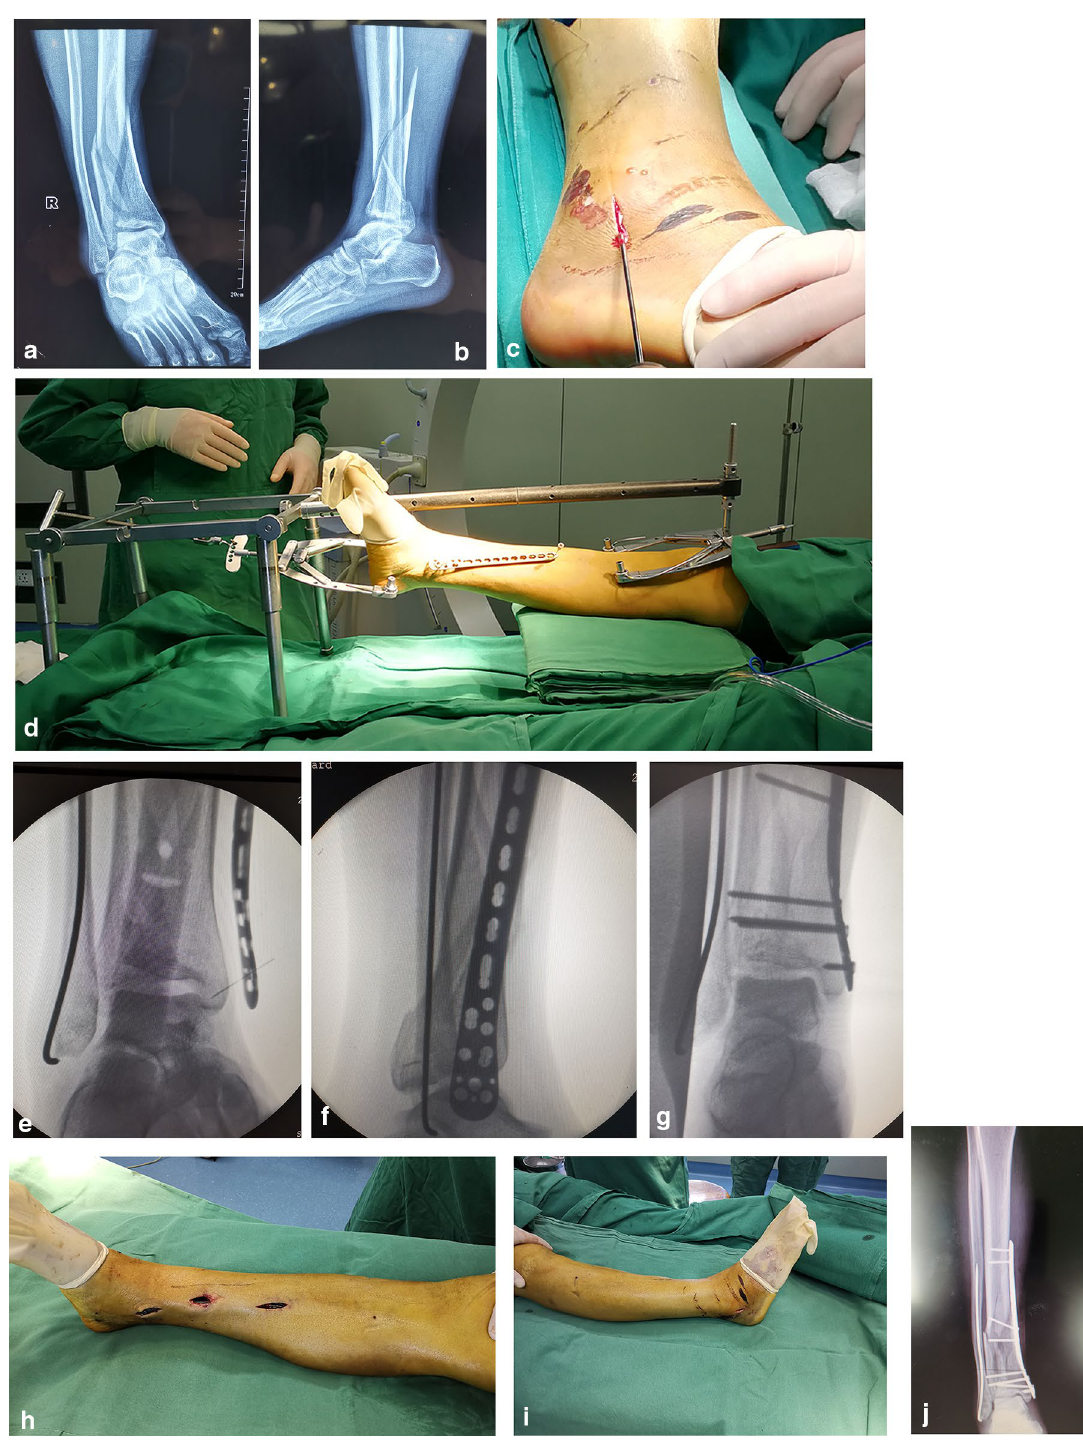
Figure 3. Fixation with MIPO technique. ( a ) and ( b ) The anteroposterior and lateral X-rays of a pilon fractures. ( c ) The fibular was fixation firstly by a 2.5 mm diameter Kirschner wire. ( d ) The syringe needles were used to locate the position of the plate to achieve minimally invasive incision. ( e ), ( f ) The plate was adjusted to the best position under fluoroscopy. ( g ) Intraoperative fluoroscopy showed that excellent fracture reduction was obtained. The surgical incision was shown in ( h ) and ( i ). ( j ) The plate was fixation with MIPO